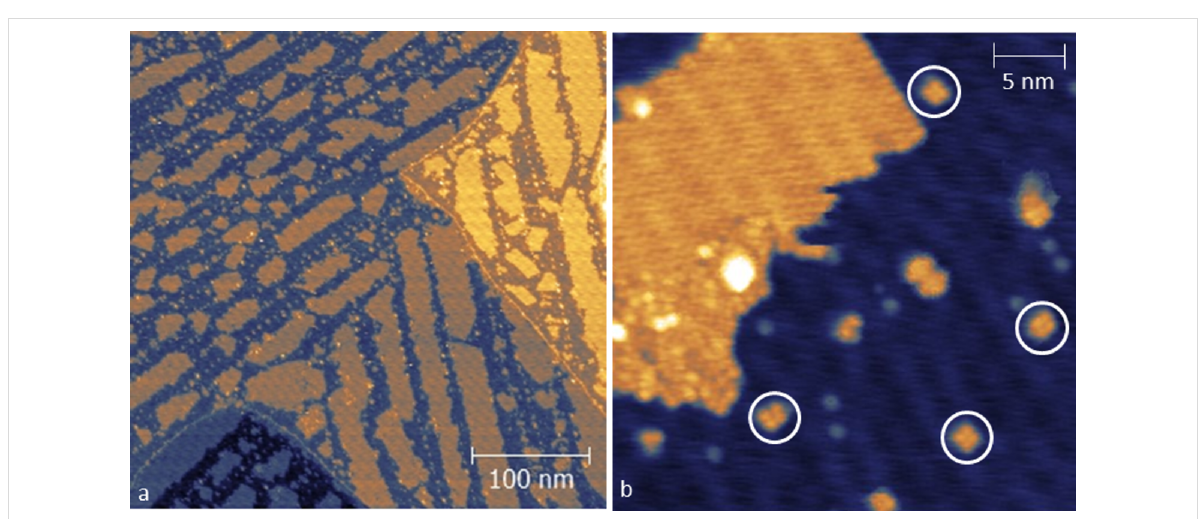
Figure 5: STM image of Au(111) surface after exposure to Fe(dpm) 3 for t 1 = 30 min (LR) at T = 30 K. (a) Size = 400 × 400 nm 2 , bias = − 2 V (empty states), I = 10 pA. (b) Size = 34 × 34 nm 2 , bias = − 2 V (empty states), I = 5